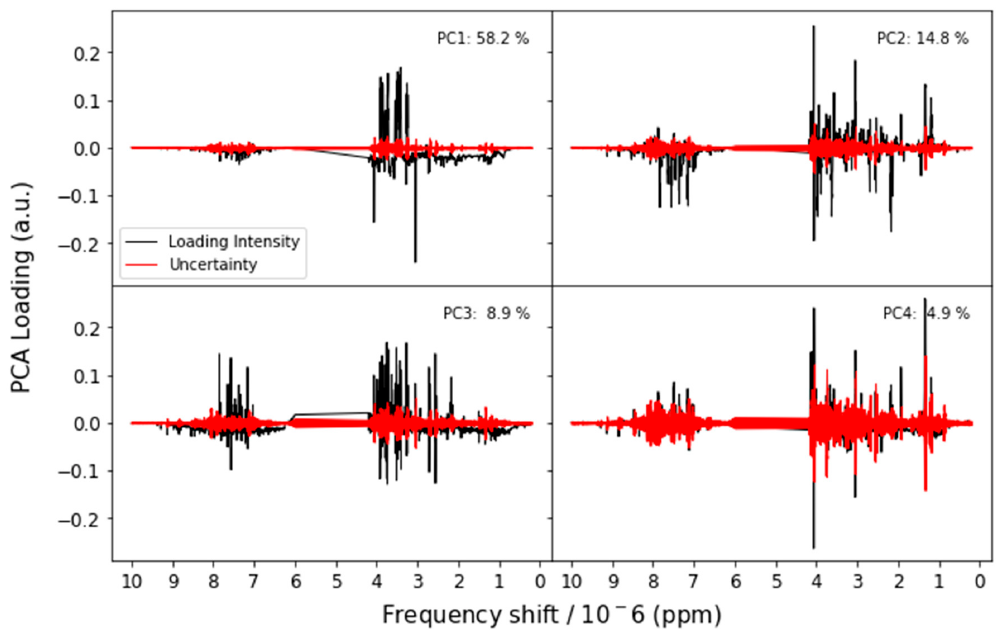
Figure 4. NMR PCA loadings with uncertainty. The uncertainty is drawn so that, if it obscures the NMR signal, the corresponding loading is not visible. Note that uncertainty is drawn as a symmetric interval around 0. There may appear to be a nonzero uncertainty in the solvent suppression region because uncertainty in the bins on either side may not be zero and there is no data in the suppression region; this apparent uncertainty is an artifact and should be